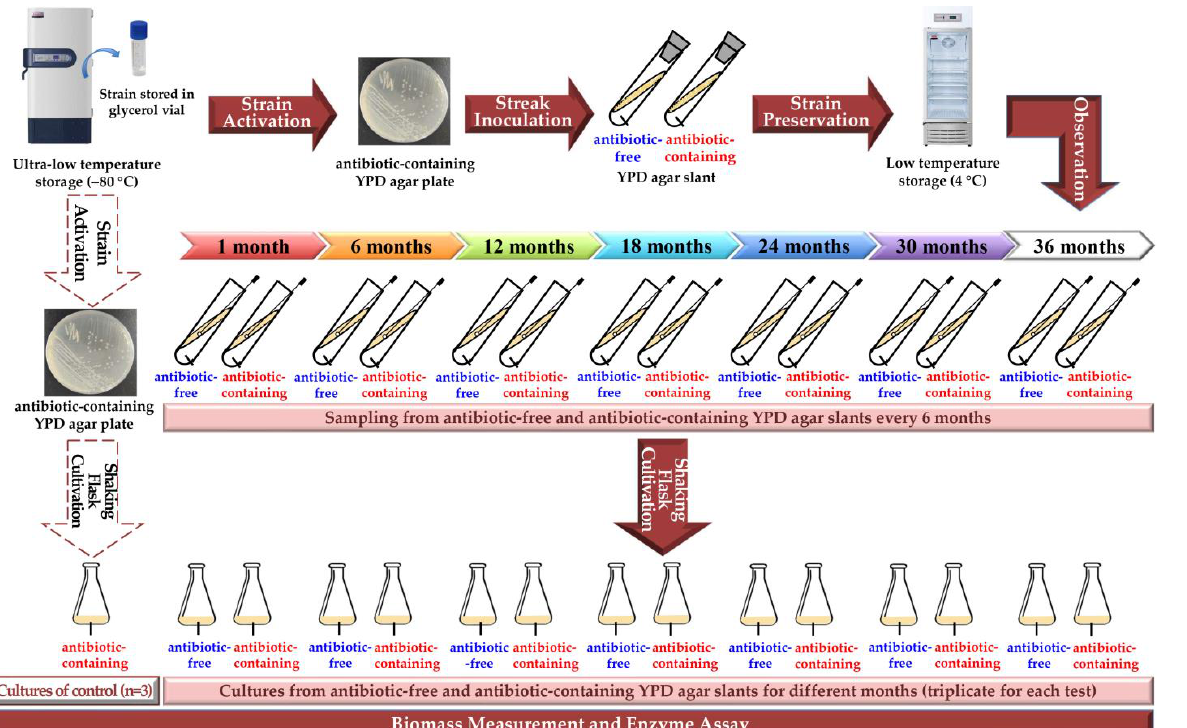
Figure 1. Scheme for detecting the influence of long-term agar-slant preservation at 4 °C on the strain vitality and the recombinant enzyme activity of the engineered yeast. vitality and the recombinant enzyme activity of the engineered